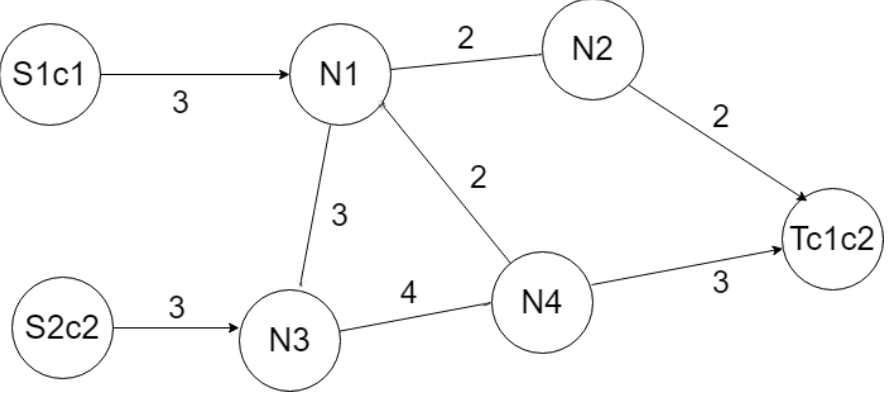
Figure 2. Flow network with multiple commodities.